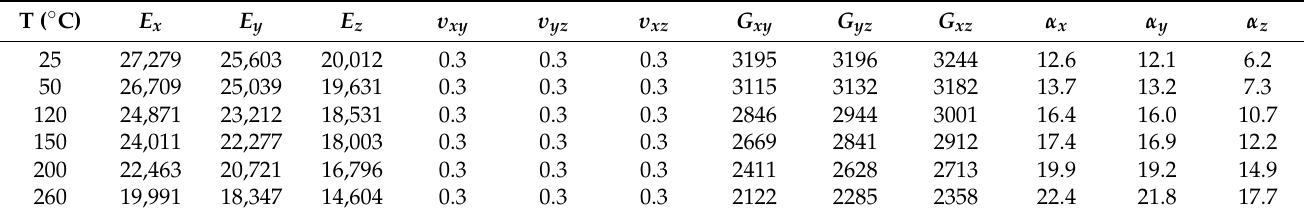
and interposer. Table 5. Temperature-dependent effective orthotropic elastic properties of the coreless substrate (unit: MPa, ◦ C/ppm).